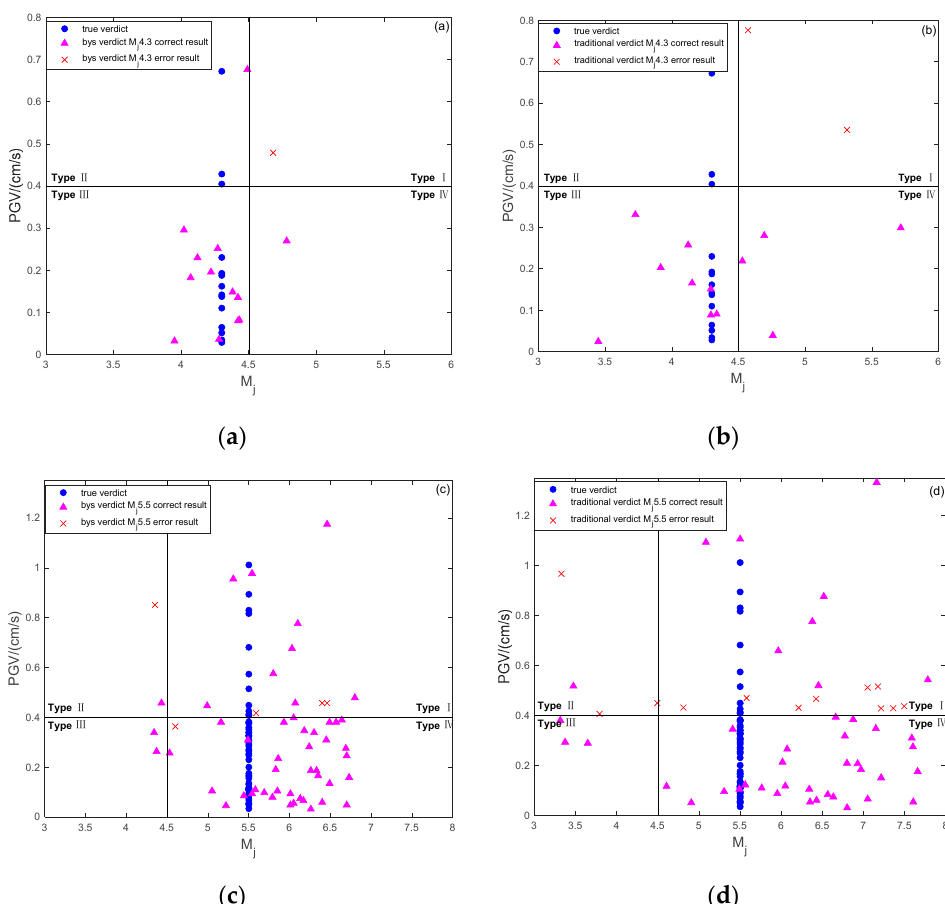
Figure 8. Comparison of the results obtained from the Bayesian-inference-based prediction methods ( a , c ) and the traditional fitting methods ( b , d ) with the true discriminant results. Table 1. Comparison of missed and false alarms of the experimental results of the two methods. Missed Alarm False Alarm Number of Missed Alarm Number of False False Alarm Rate Missed Alarms Rate Alarms Bayesian predic ‐ 2 2.94% tion method Traditional fitting method